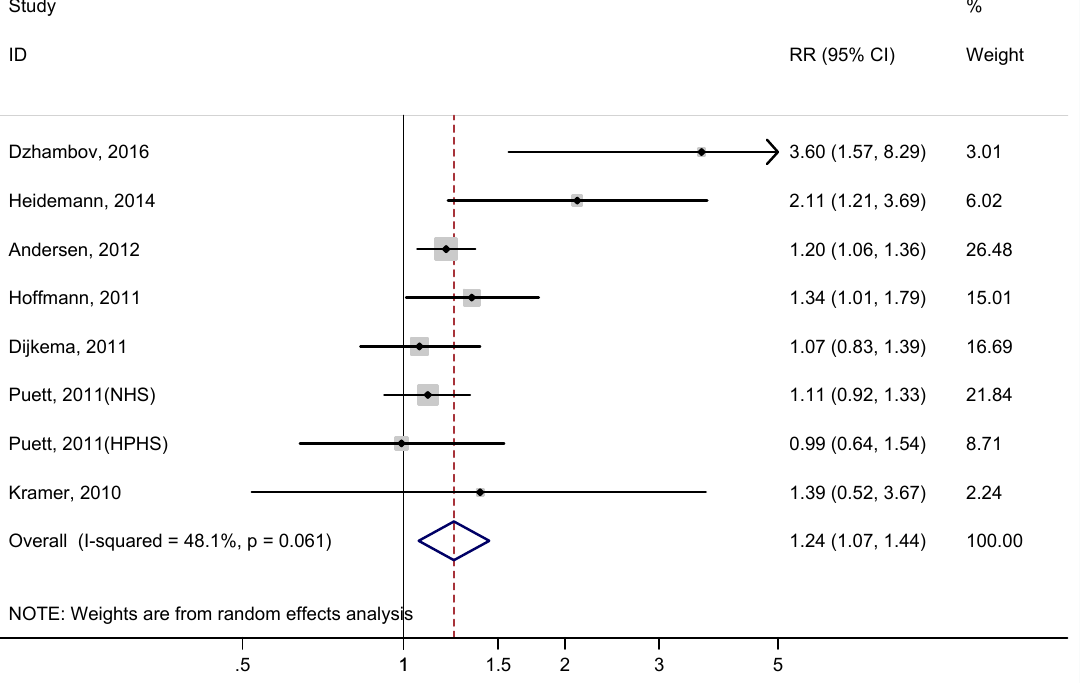
Figure 2. Unadjusted relative risk (RR) of type 2 diabetes associated with residential proximity to major roadways.